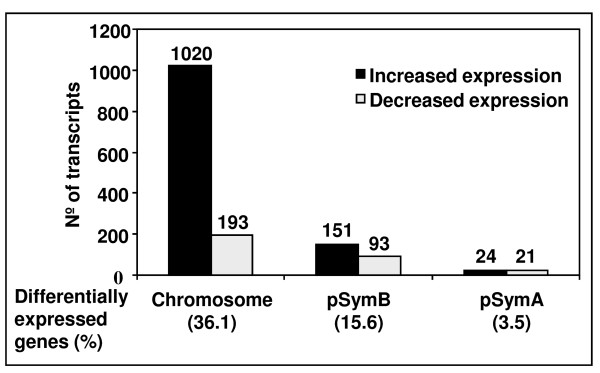
Distribution of differentially expressed genes in function of the S. meliloti 1021 replicons. The histogram shows the number of differentially expressed genes obtained when the tolC mutant transcriptome was compared to the wild-type strain and their distribution on the chromosome and the two megaplasmids pSymA and pSymB.